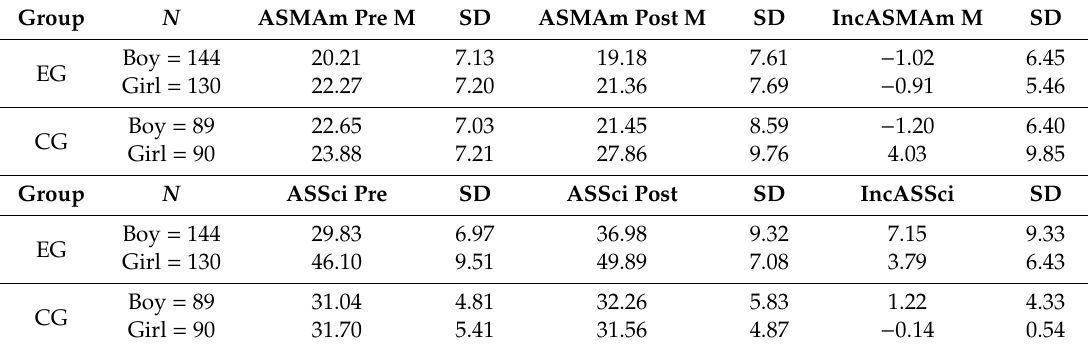
Table 4. Mean, M, and standard deviation, SD, of attitude towards mathematics and attitude